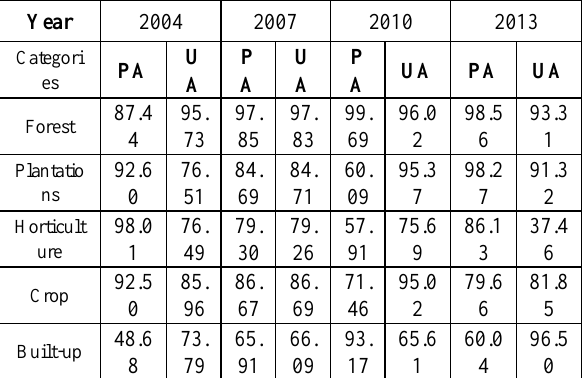
Table 2. Land use changes from 2004 to 2022.